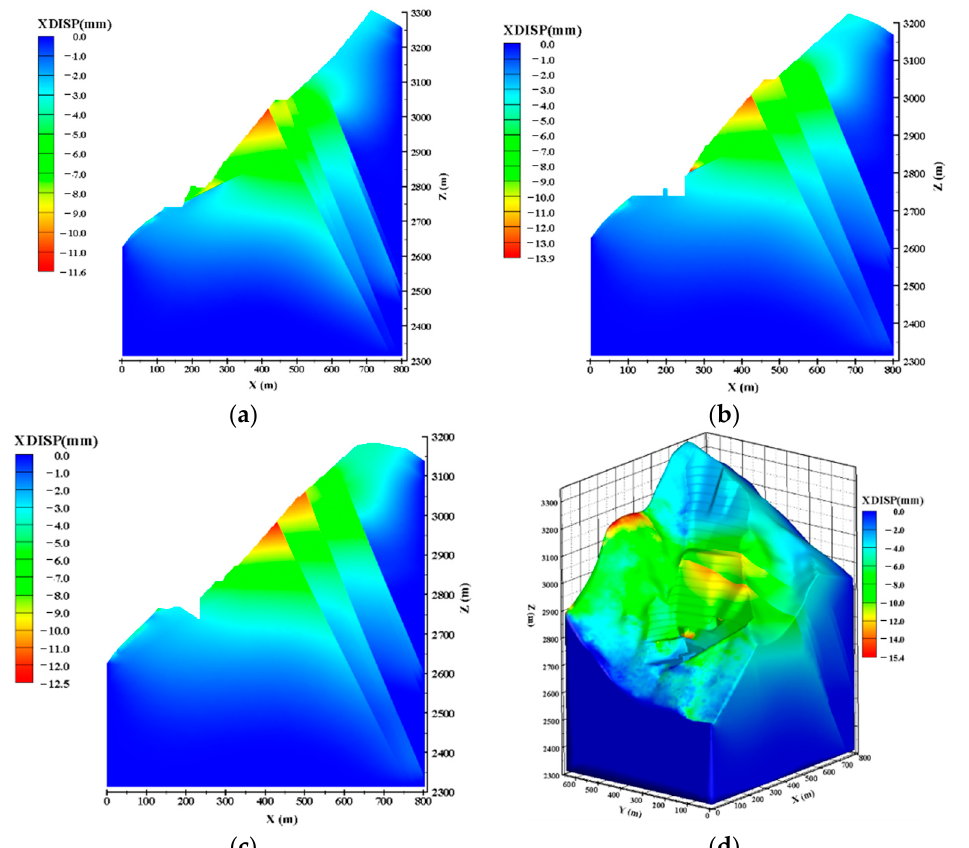
Figure 10. Transverse riverward displacement distribution under condition III. ( a ) Profile 5; ( b ) profile 10; ( c ) profile 13; ( d ) entire body.